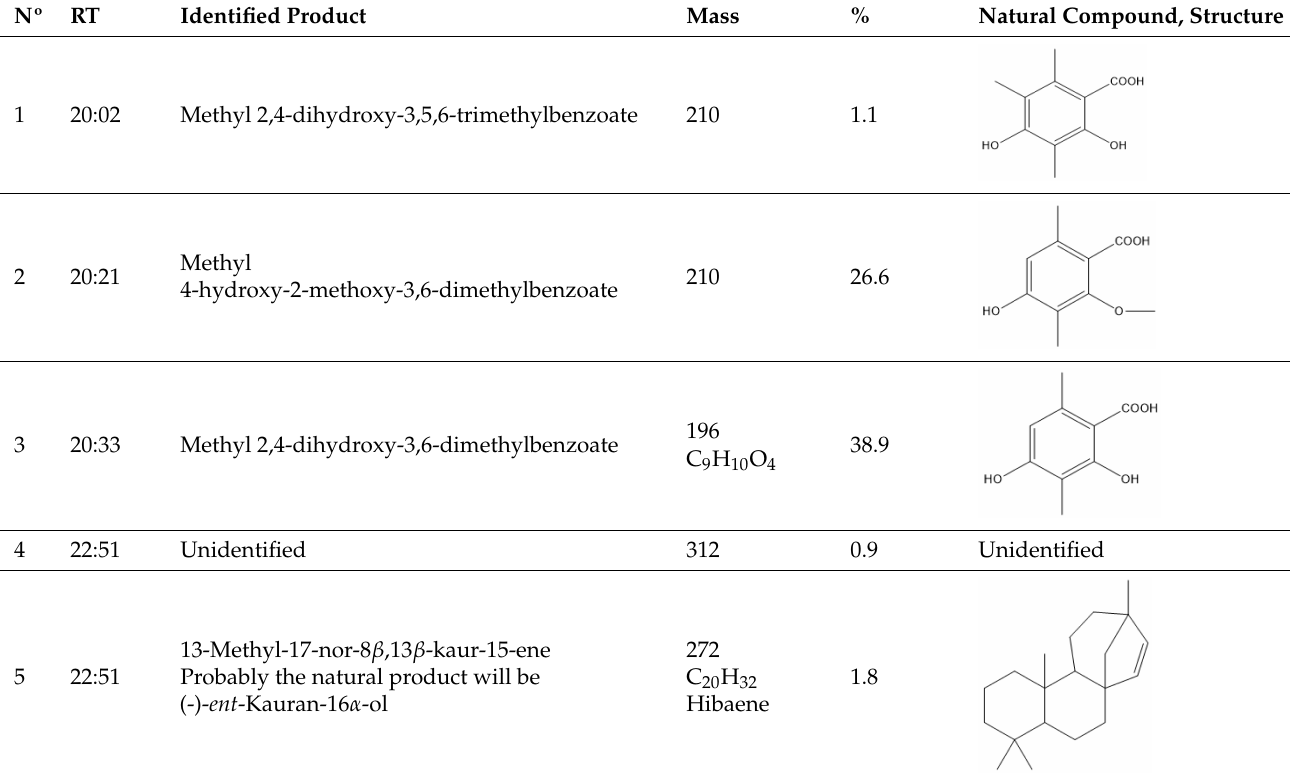
Table 3. Sample Parmotrema hypoleucinum (in Olea europaea ), Hexane extract part insoluble in MeOH esterified whit diazomethane, 1-Cires